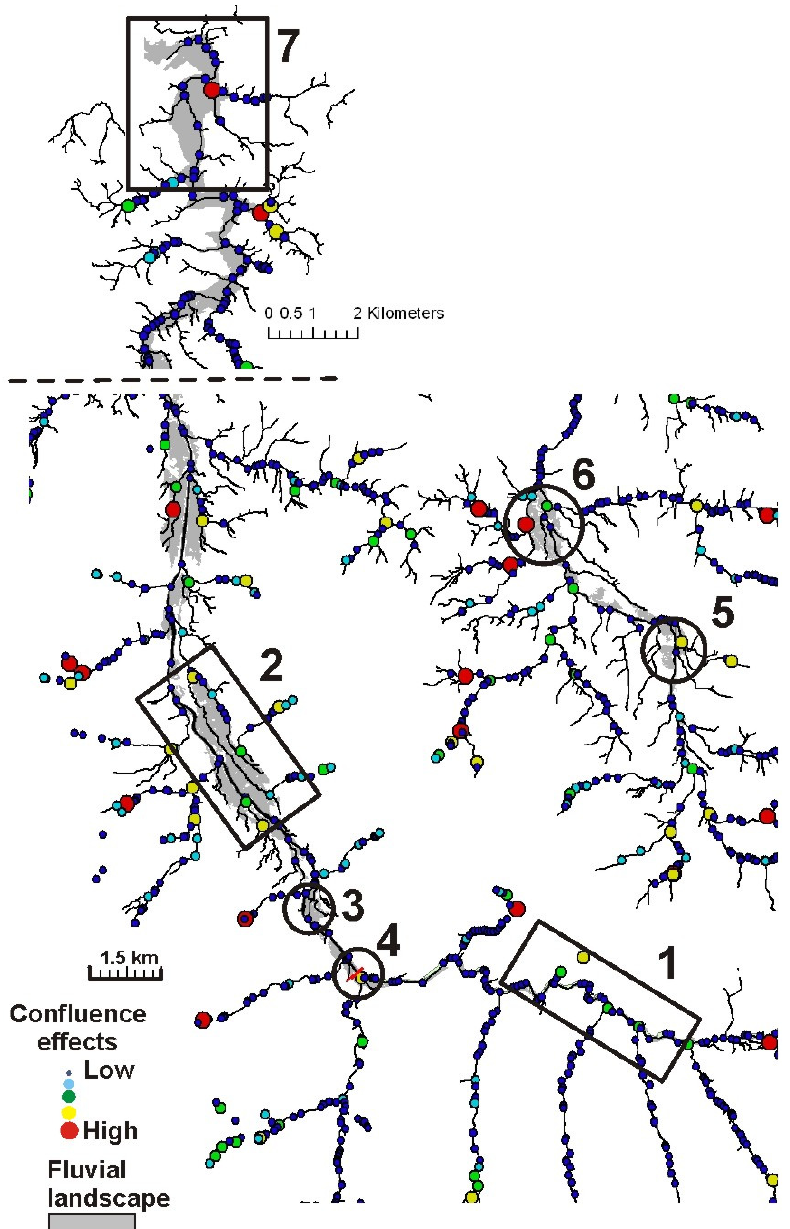
Fig. 10. The analysis of fluvial landscapes in the Pas River network provides a catchment scale context for restoration planning. Four types of fluvial landscapes are identified: (A) narrow valleys-string of pearls (#1), (B) broad valleys-complex floodplains (#2), (C) confluence related areas and valley transitions (#3, 4, 5 and 6), and (D) lower riverine-estuarine environments (#7). Not all sites that fall into these categories are shown. The shaded reconstructed riverine landscape denotes areas located within one and two bankfull